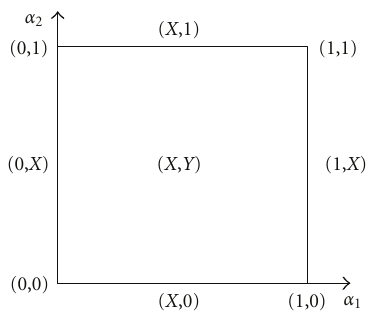
Figure 2: Illustration of the Nash equilibria space where ( α 1 , α 2 ) denotes the power allocation strategy for both operators 1 and 2, in the first